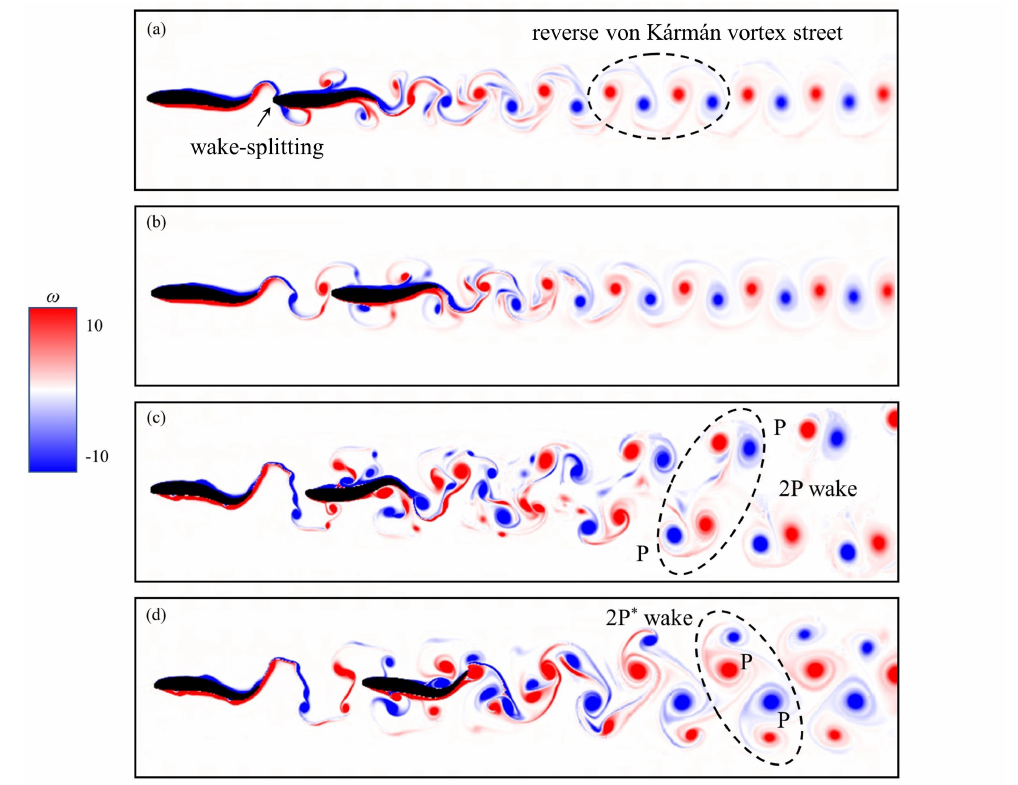
Figure 4. Instantaneous vorticity contours of two self-propelled fish in the tandem arrangement at swimming parameters ( a ) d 0 = 0.1 L , A = 0.1 L , δφ = π /2, ( b ) d 0 = 0.1 L , A = 0.1 L , δφ = 3 π /4, ( c ) d 0 = 0.5 L , A = 0.2 L , δφ = π /2, and ( d ) d 0 = 0.5 L , A = 0.2 L , δφ = π /4. Other parameters are the same: T = 1.0 T c and λ = 1.0 L